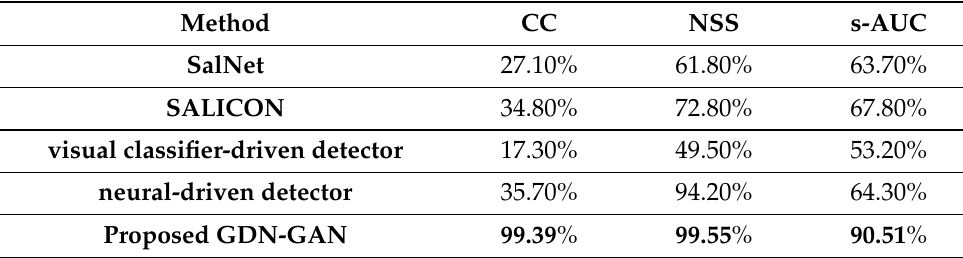
Table 7. Saliency performance comparison between the proposed GDN-GAN and state-of-the- art